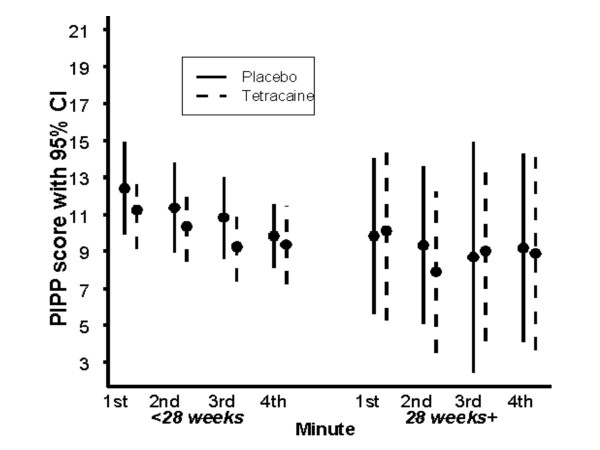
PIPP scores according to gestational age.